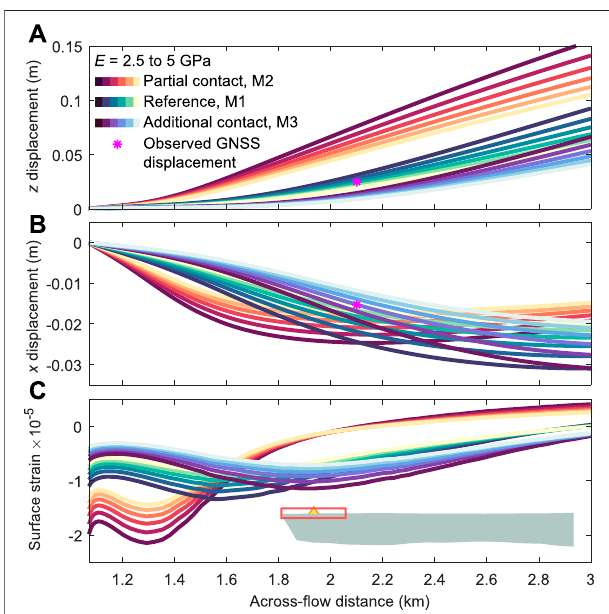
FIGURE 9 | Panel (A) is the vertical component z of the ice surface displacement foreach ofthethree margin boundary conditions and arangeof apparent Young ’ s modulus values ( E = 2.5 – 5 GPa, dark to light shading, respectively). Panel (B) is the horizontal component x of the ice surface displacement, with negative displacements indicating motion toward the margin. Panel (C) is the surface strain (engineering strain) computed for each model element at the ice surface. The tide forcing applied to generate the upward de fl ection in this example is the spring high tide (+37 cm). The red inset box indicates the section of the glacier surface shown in each plot. Opposite downward bending of the ice layer is shown in Supplementary Section 3.4